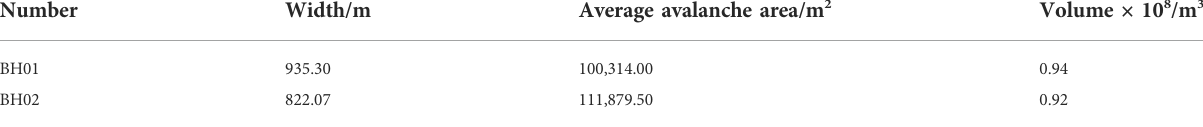
TABLE 7 Characteristics of potential collapse landslide in Zhamunong gully (modi fi ed after Li et al.,